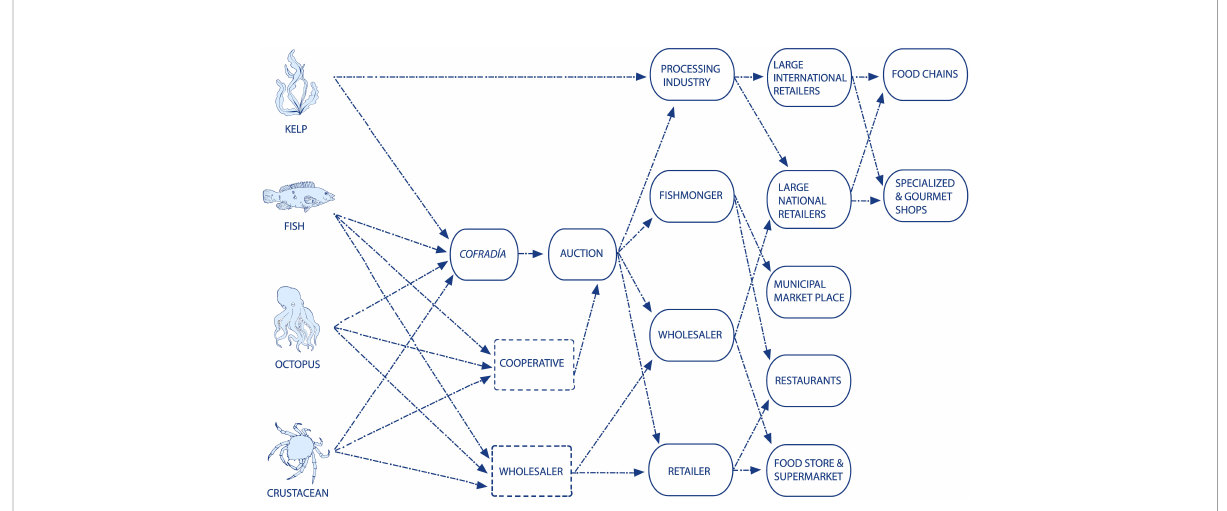
FIGURE 6 Distribution of kelp harvested and marine resources associated along the commercial chain in the study